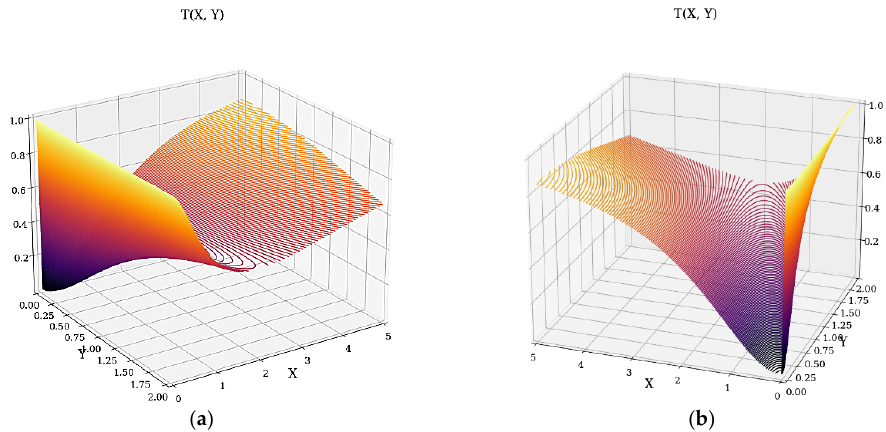
Figure 2. ( a , b ) The 3D dependencies T = T(X,Y) from two perspectives. The 2D dependencies of T on X and Y are depicted in Figure 3a,b.